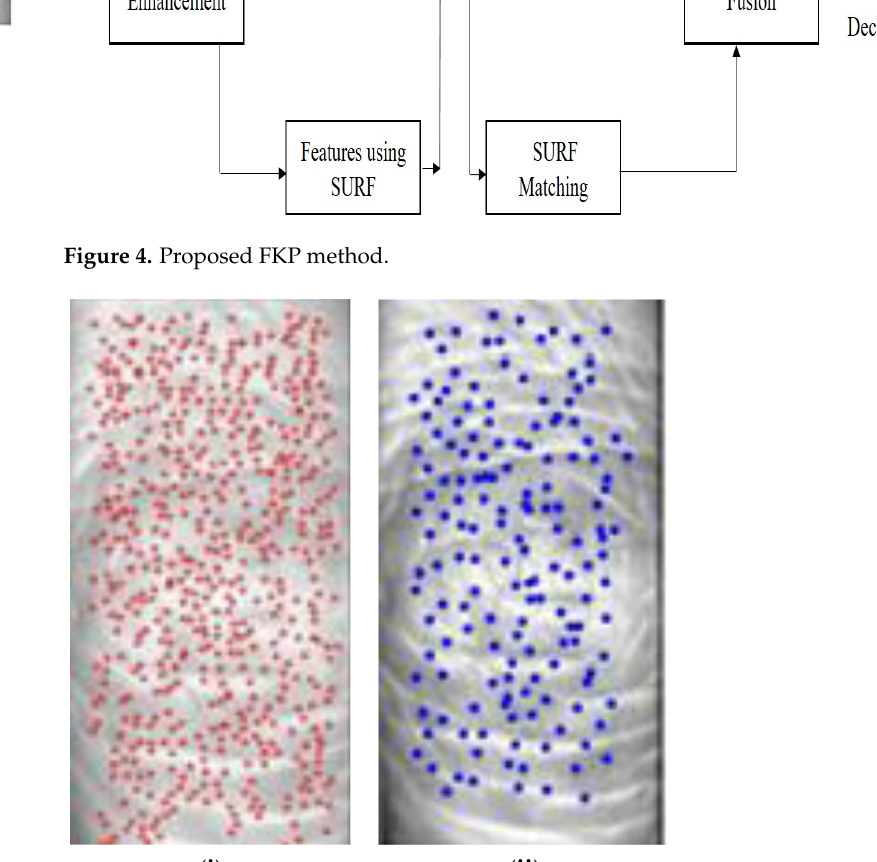
Figure 4. Proposed FKP method .